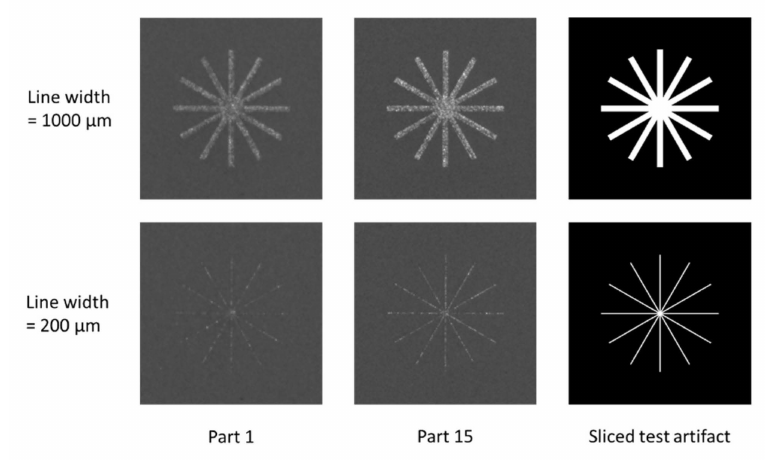
Figure 4. Cropped monitoring images with different line widths.